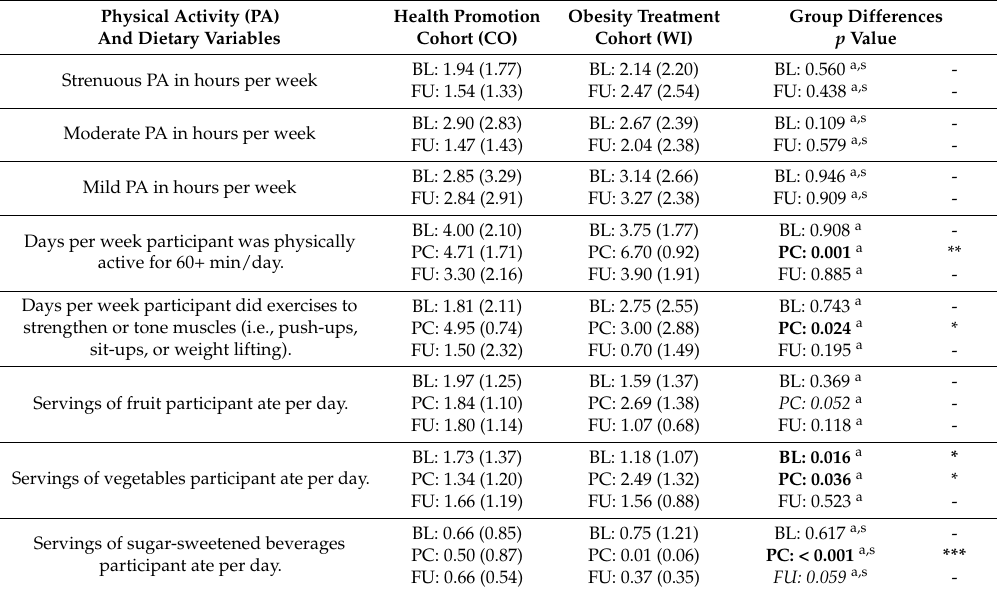
Health Promotion Obesity Treatment Group Differences p Value Cohort (CO) Cohort (WI)